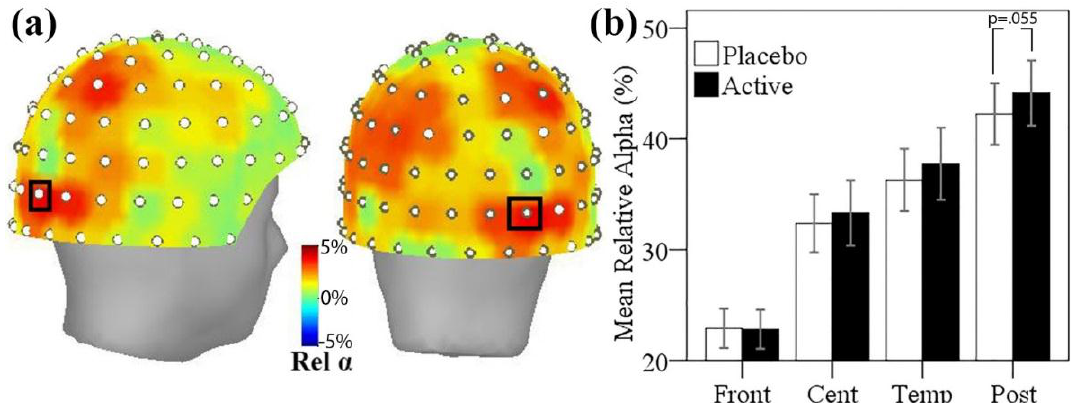
Figure 4. ( a ) Topographic maps of mean relative alpha difference between active and placebo visits viewed from the right side and posterior views (positive numbers = greater at active visit). The sensor showing a trend of p < 0.1 is marked with black rectangle; ( b ) Mean relative alpha power at each treatment visit, averaged across magnetometer sensors within frontal (Front), central (Cent), temporal (Temp), and parieto-occipital (Post) regions. Error bars ± 1 SE. Nutrients 2016 , 8 , 53